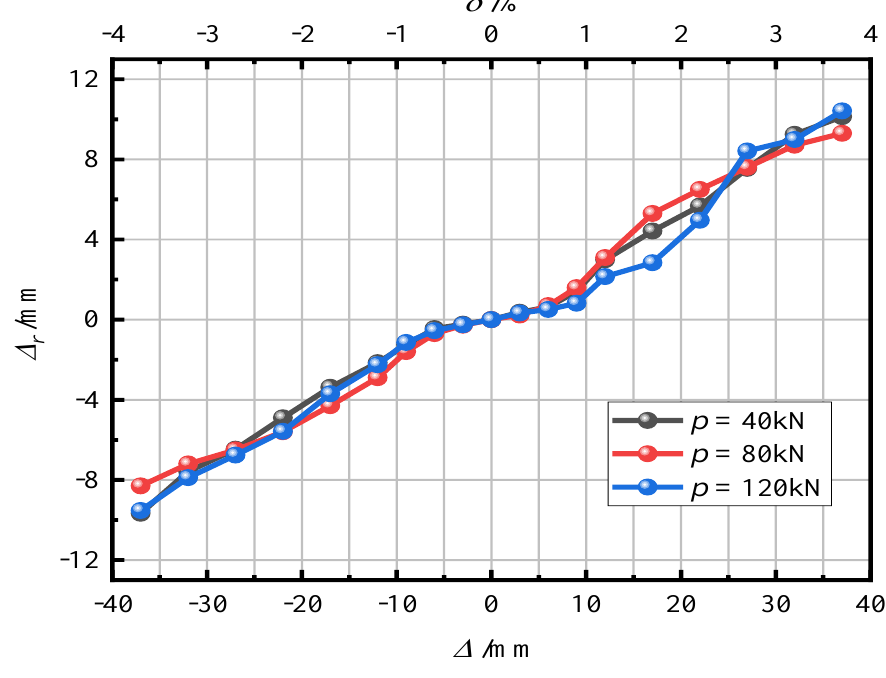
Figure 20. Residual displacement.